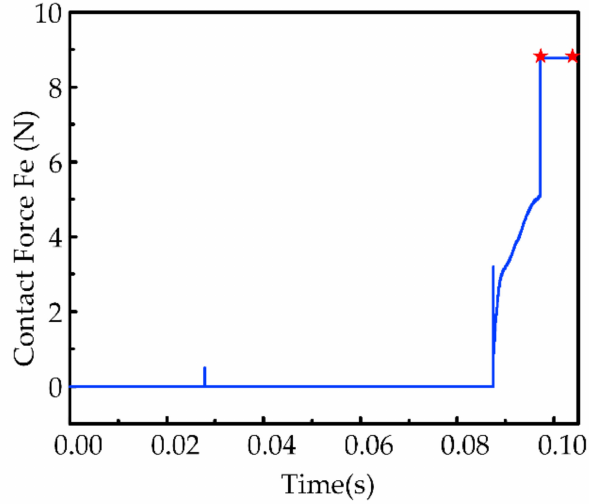
Figure 13. Contact force at the end of the